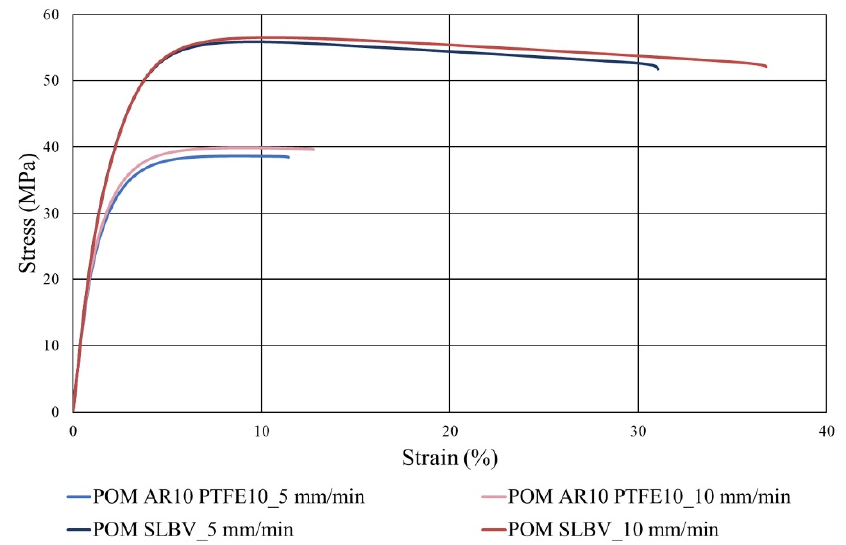
Figure 5. Stress–strain diagram recorded during the tensile test according to DIN EN ISO 527-2 (type 1A), n = 5.